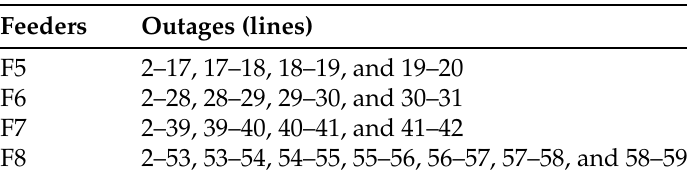
Table 3. Critical contingency